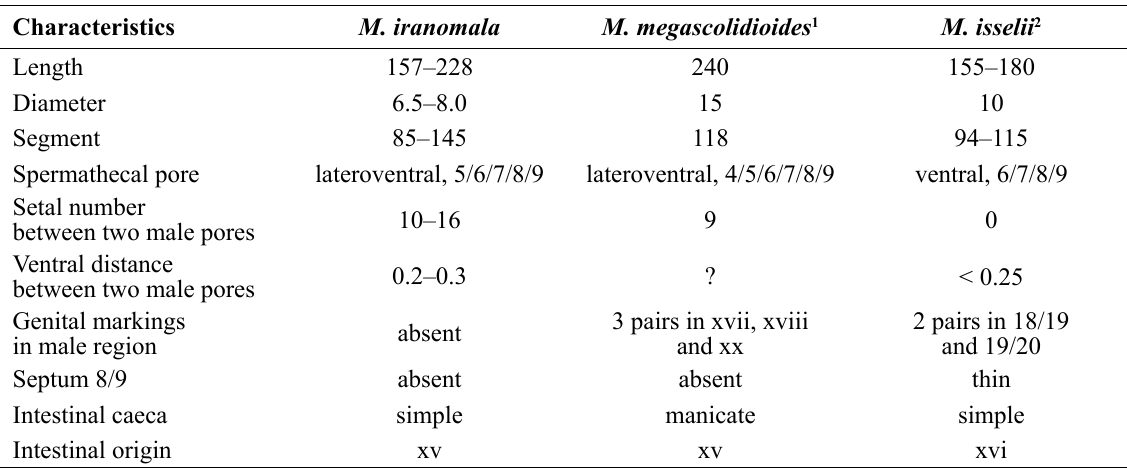
Table 3. Comparison between M. iranomala sp. nov., M. megascolidioides (Cognetti, 1908) and M. isselii (Goto & Hatai, 1899) sharing location of male pores not in segment